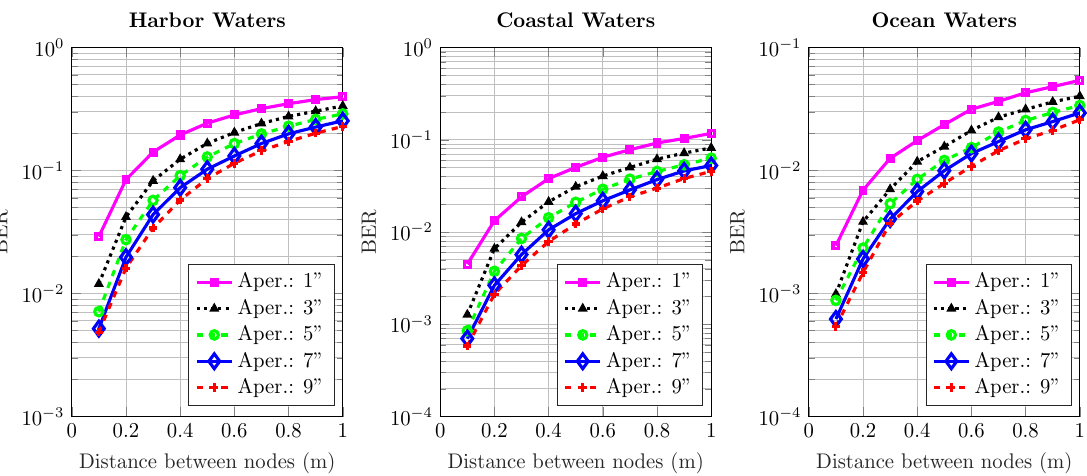
Figure 6. Effect of increasing transmission distance and aperture on the BER performance of harbor, ocean, and coastal waters for 1 ◦ receiver